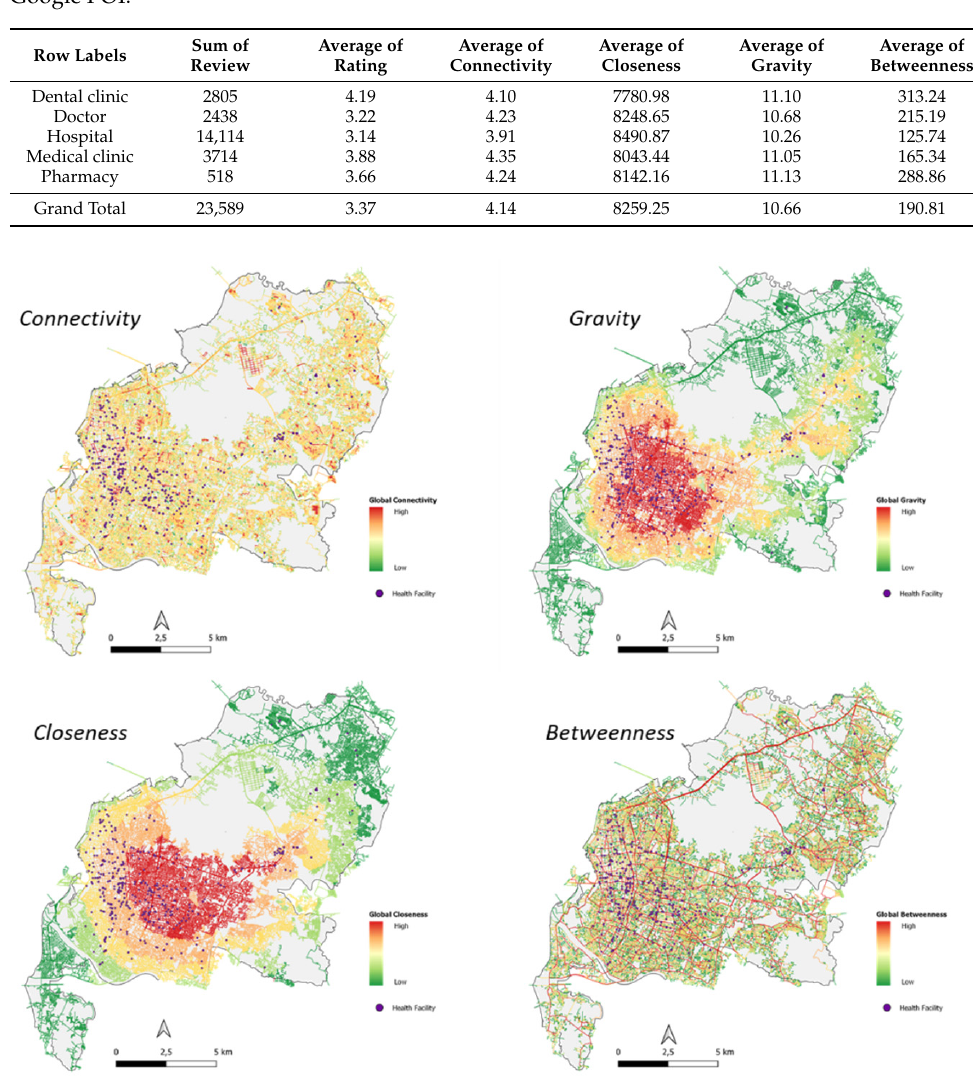
Figure 10. Global Spatial Review Configuration Map and Health Facility.